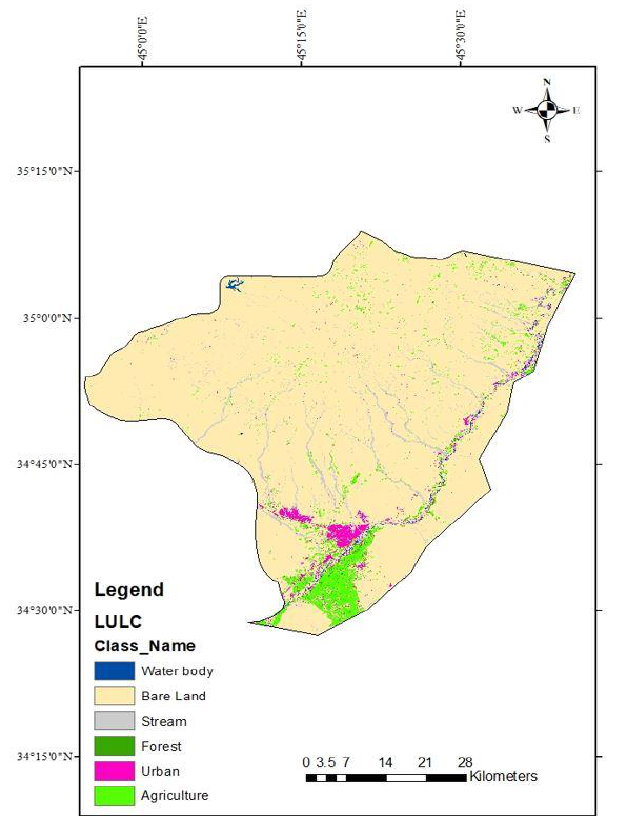
Figure 7. LULC map of the study area.